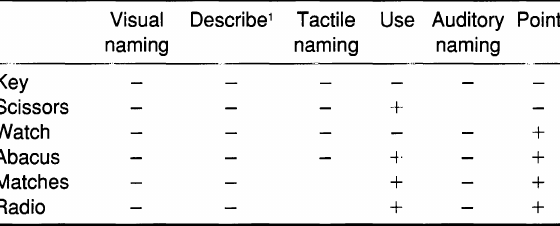
TABLE II. Result of object identification test